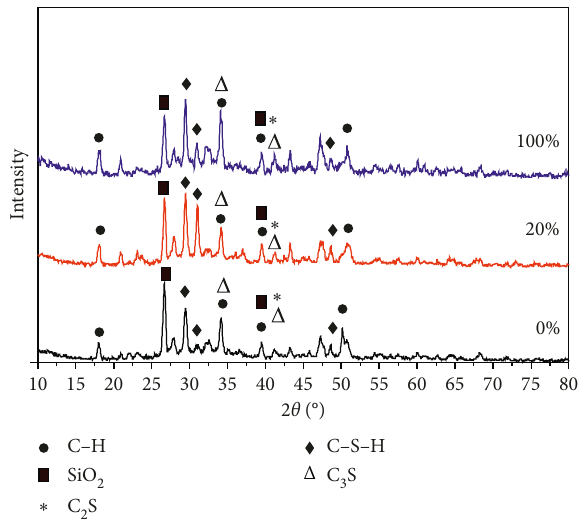
Figure 11: X diffractograms of samples at a curing age of 28